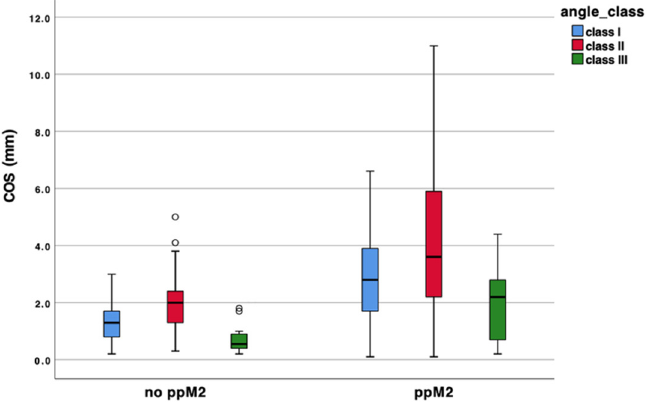
Table 4. COS depth and age.